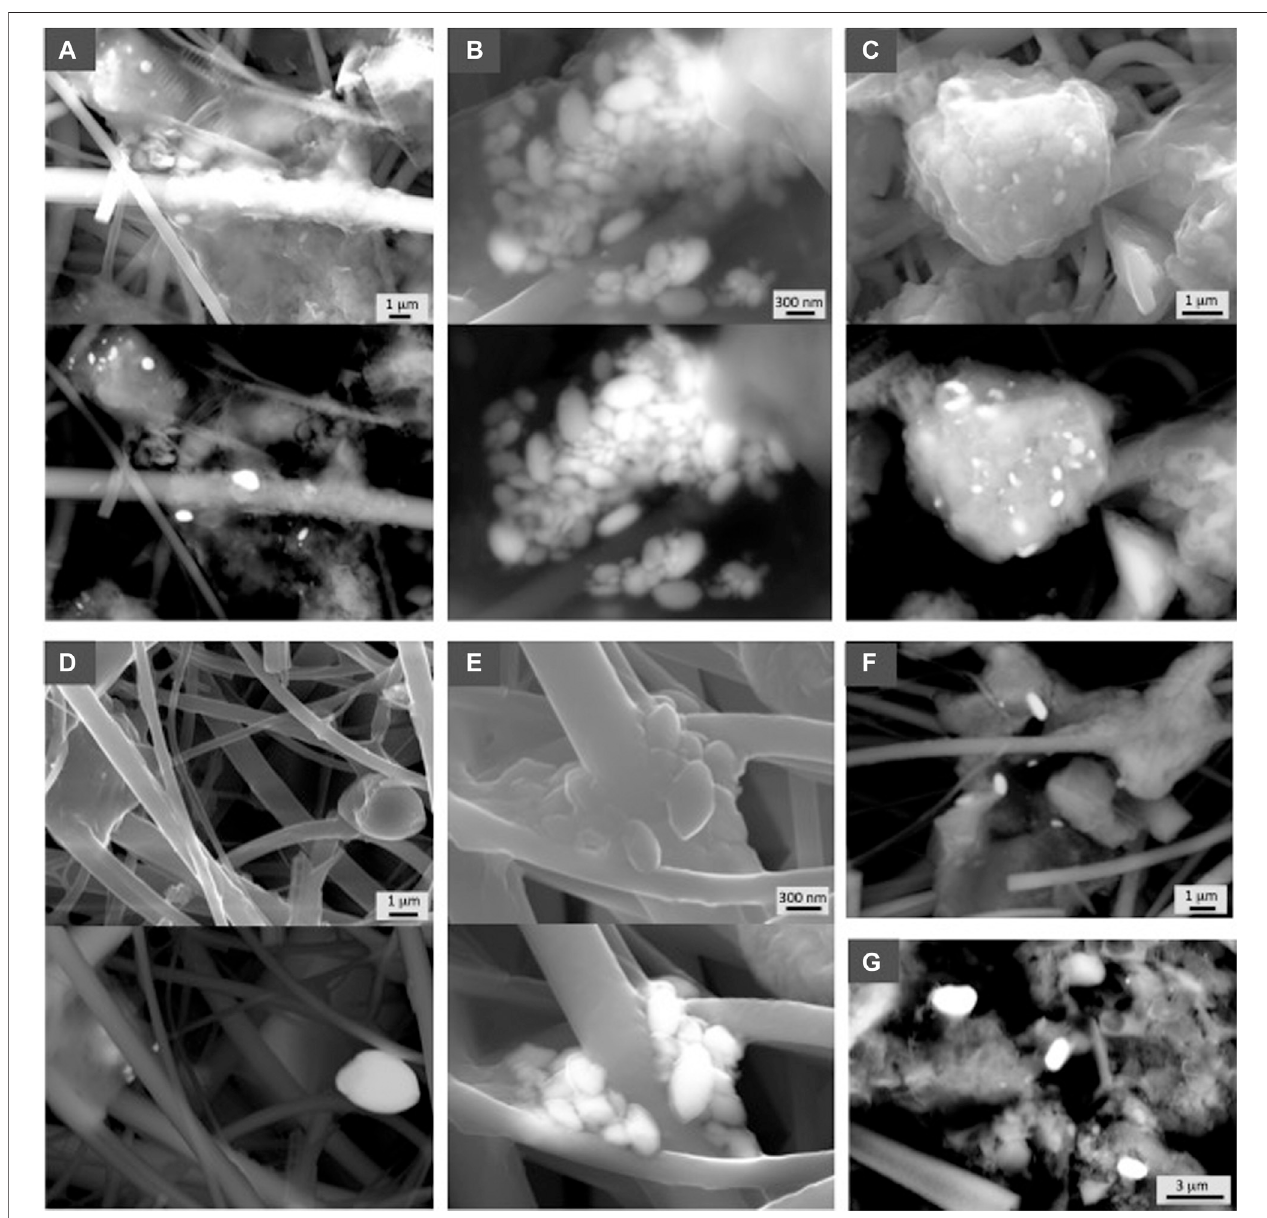
FIGURE2| SEMphotographsshowingrepresentativeexamplesofbaritefromthePaci fi csector.Samplesareindicatedin Table1 .Bothsecondaryelectronandin backscattered electron (BSE) mode at 30 kV are shown in each sample. (A) CS4 (267 m), (B) CS9 (99 m), (C) CS10 (149 m), (D) CS20 (151 m), (E) CS 17 (503 m). (F) (CS 23) and (G) (CS 5) correspond to the deepest fi lter samples obtained at this ocean sector, 603 and 535 m, respectively.